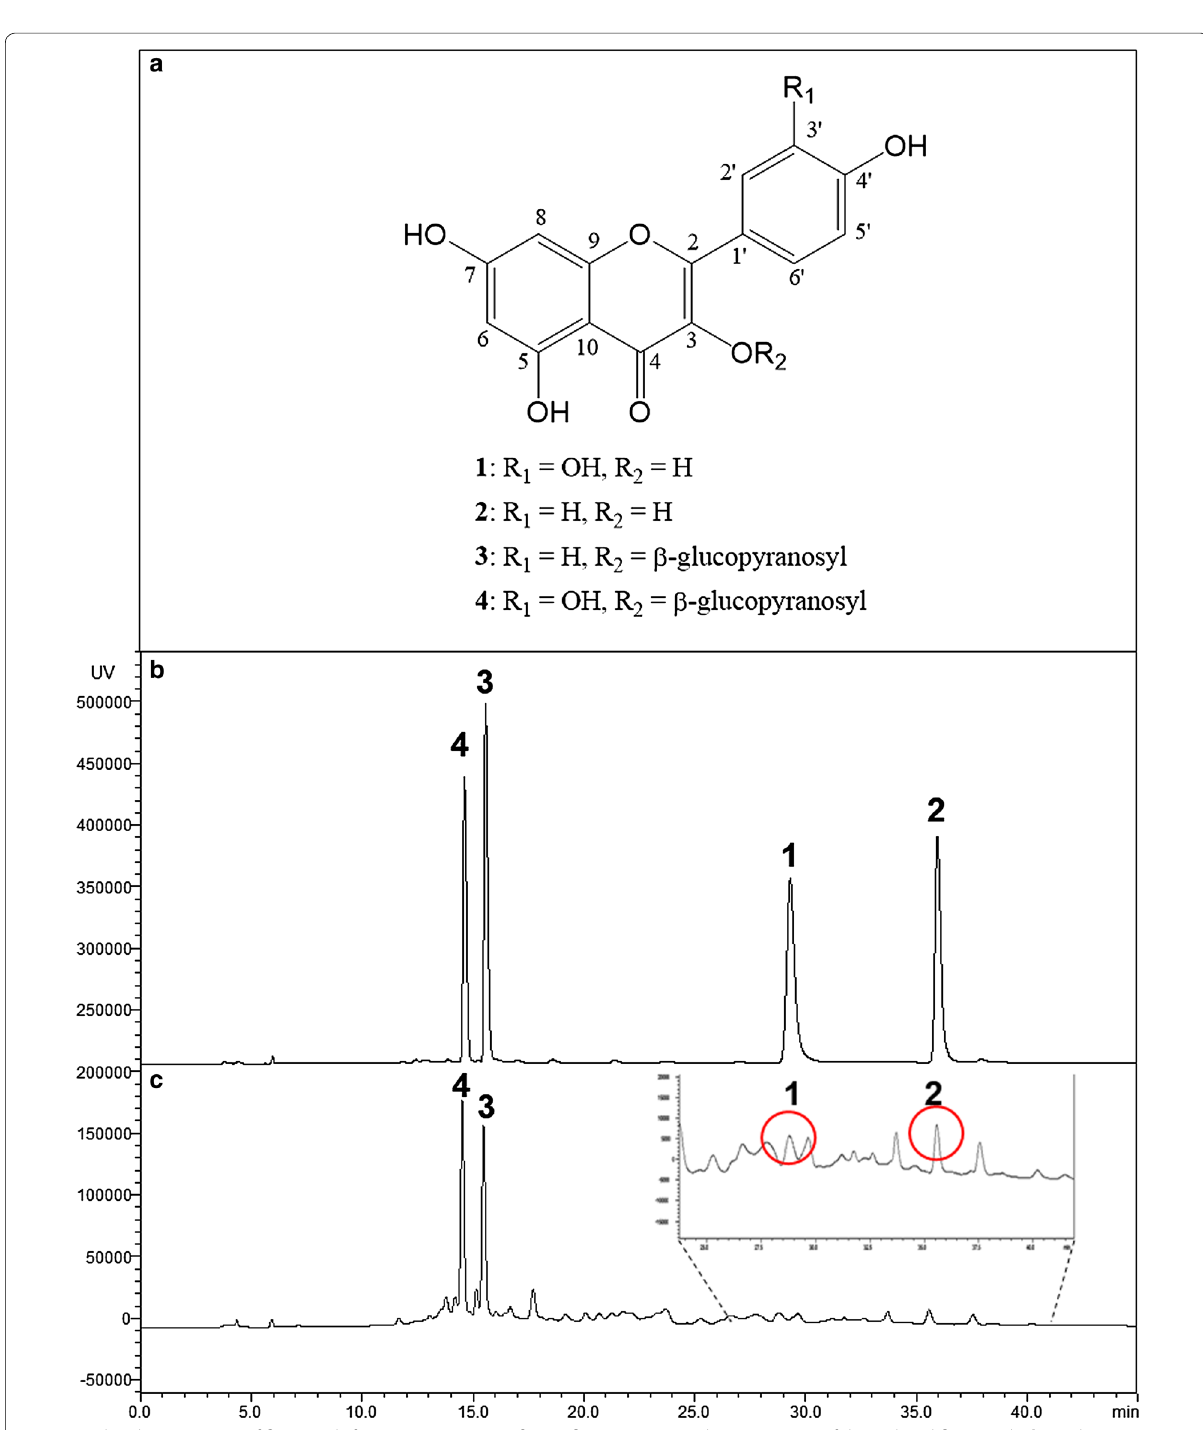
Fig. 4 Molecular structures of flavonoids from Begonia semperflorens flowers. a HPLC chromatogram of the isolated flavonoids ( b ) and EtOAc fraction ( c ) from the flowers of Begonia semperflorens . 1 (quercetin, rt: 29.3 ′ ), 2 (kaempferol, rt: 36.0 ′ ), 3 (astragalin, rt: 15.6 ′ ), 4 (isoquercetin, rt: 14.6 ′